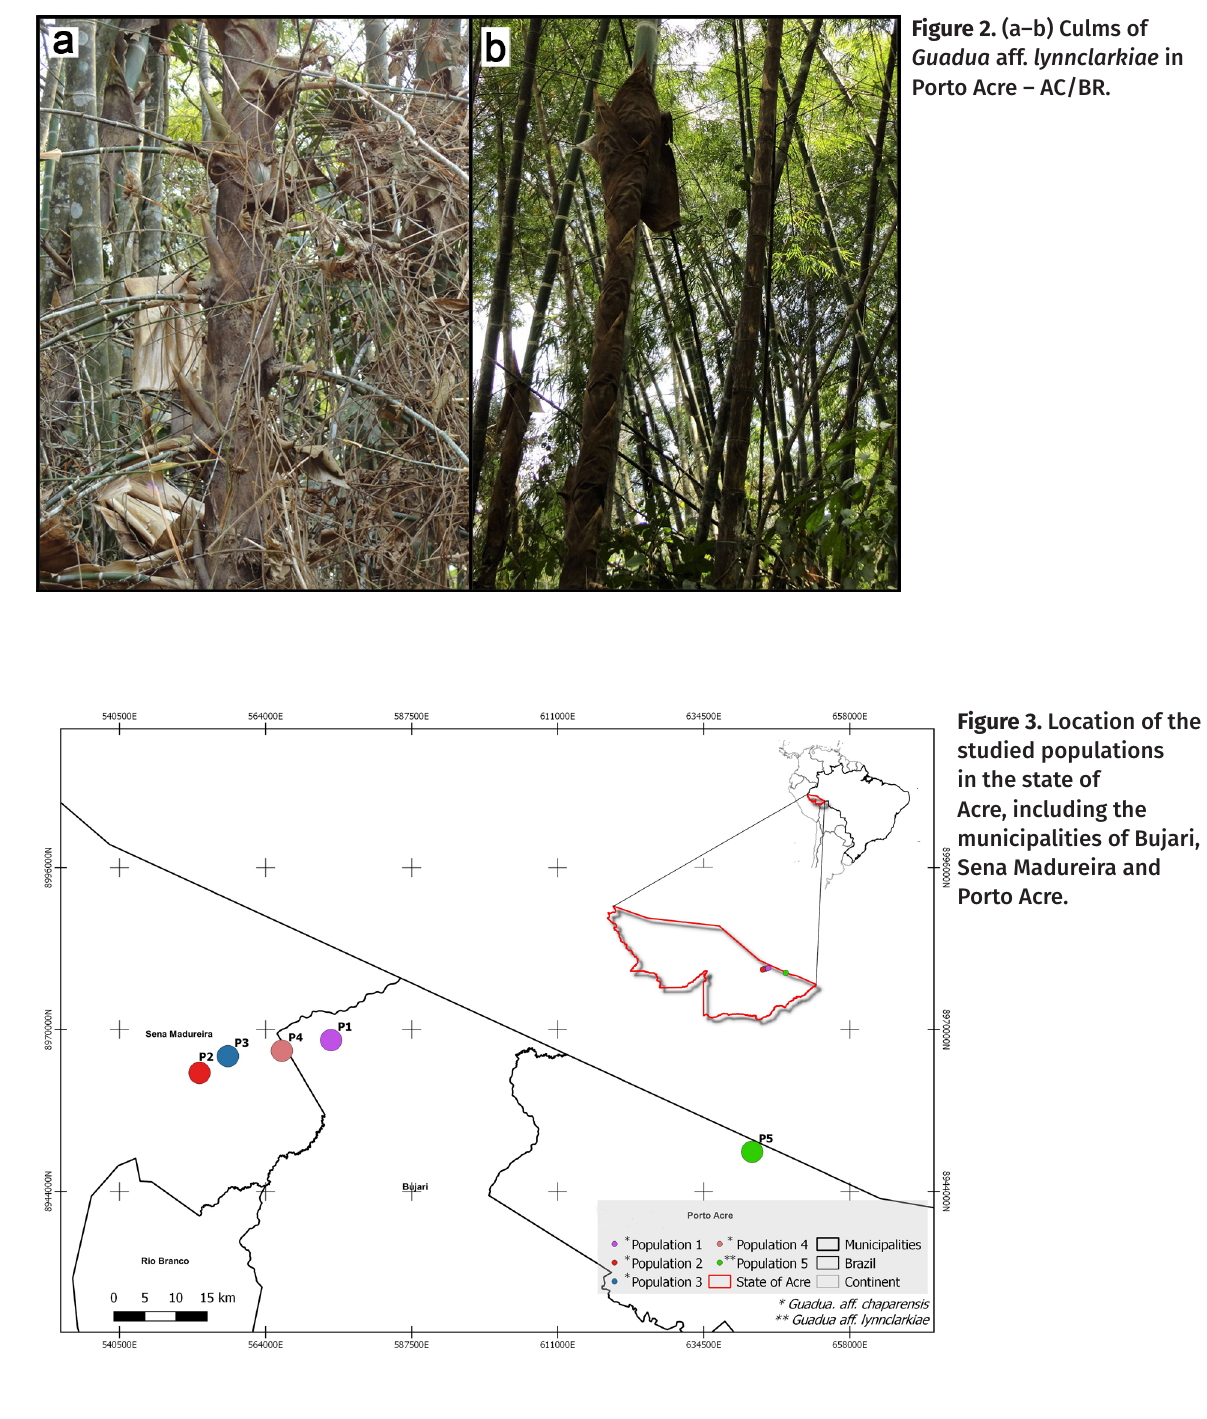
Figure 2. (a–b) Culms of Guadua aff. lynnclarkiae in Porto Acre – AC/BR.